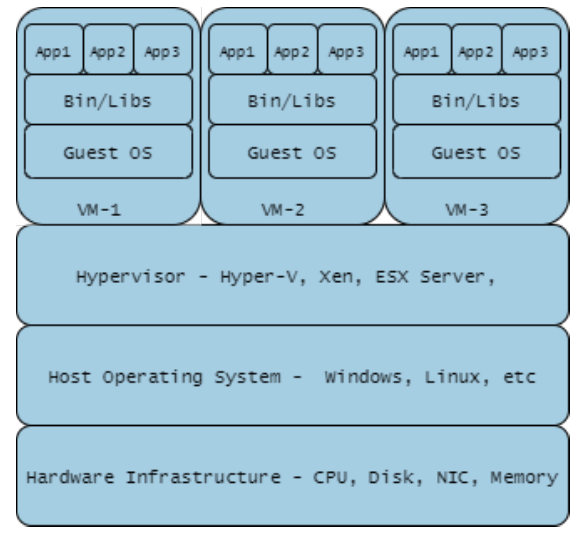
Figure 12. Virtualisation